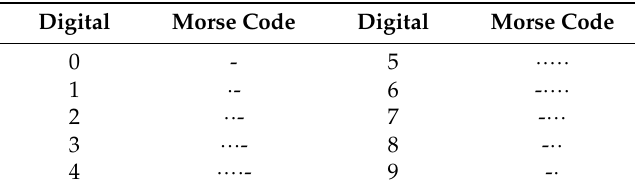
Table 1. Morse code table (short version).